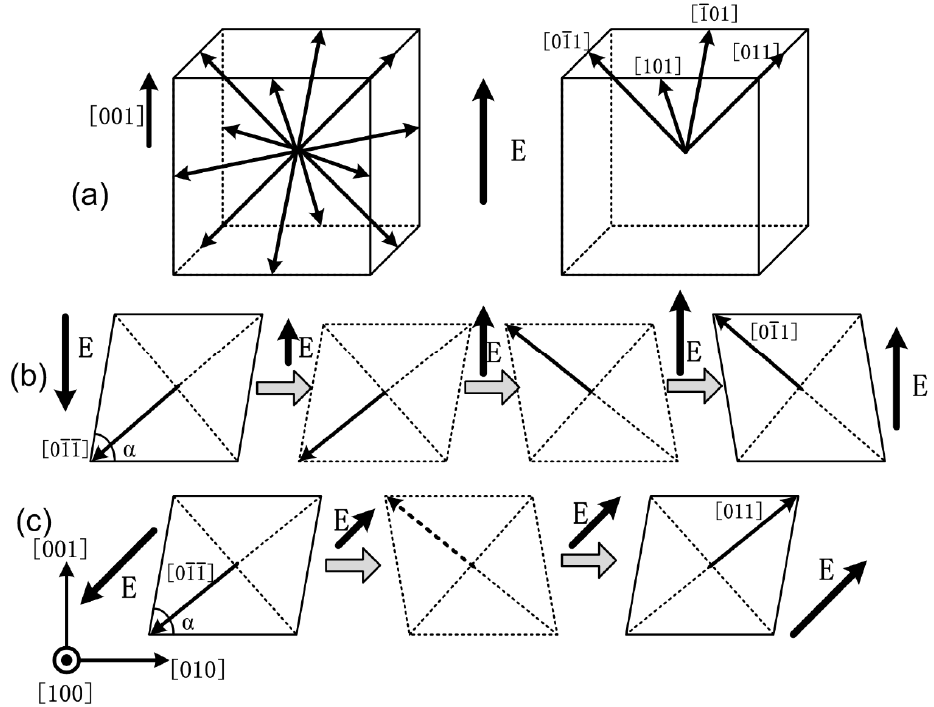
Figure 13. (Color online) ( a ) Schematics of domain configurations for (100) pc -oriented orthorhombic KNN25/75 crystals. The left panel: in the unpoled state, the polarization vectors are along twelve equivalent (110) pc directions. The right panel: poled along (100) pc , only 4 polarization directions are left; ( b ) The domain switching process of one domain in (100) pc crystals and ( c ) in (110) pc crystals. Reprinted with permission from [28]. Copyright 2014 Royal Society of